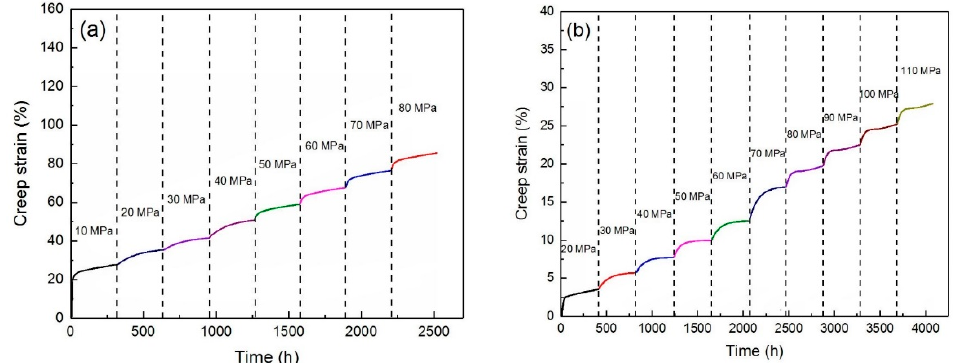
Figure 4. Creep diagram at 150 °C at different stress levels: ( a ) unreinforced alloy, and ( b ) ZK60/SiC p composite.